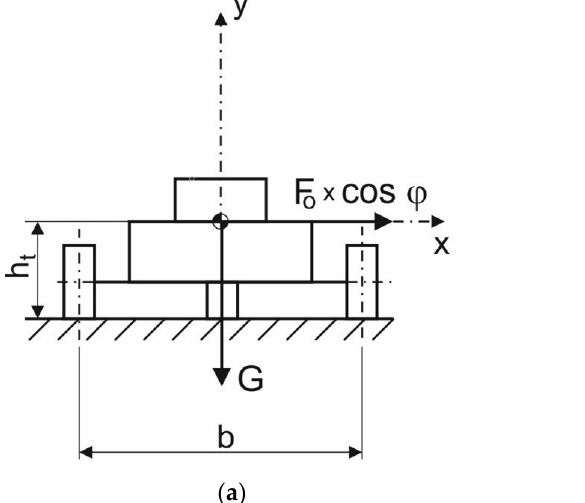
( b ) Figure 11. Position of the center of gravity: ( a ) The E3-cycle; ( b ) E3-cycle along with the model rider. The way the E3-cycle passes through the curve affects its stability condition (8). By means of this mathematical scheme, it is possible to observe how large a centrifugal force effect the E3-cycle can overcome. The stability condition for the E3-cycle from Fig- ure 10 is given by Formula (8):